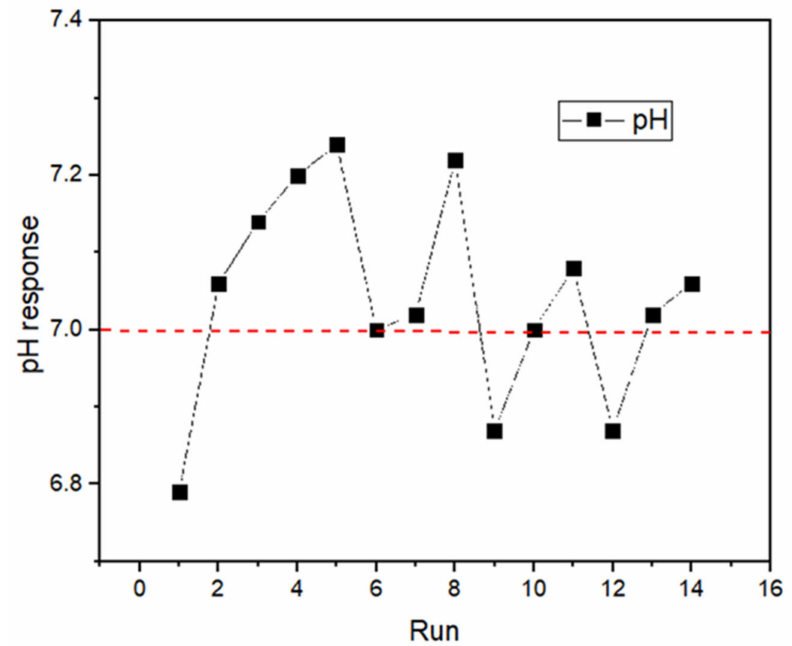
Figure 1. pH response per CCD experimental